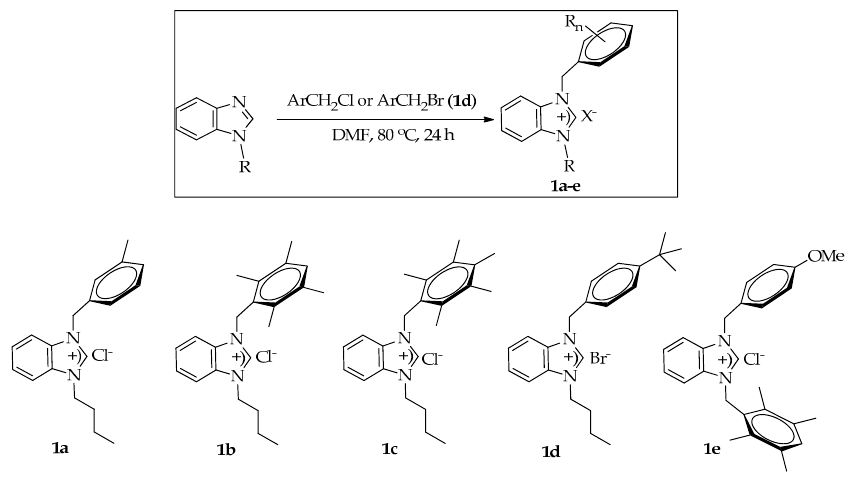
Table 1. Physical and spectroscopic properties of new compounds 1 and 2 .